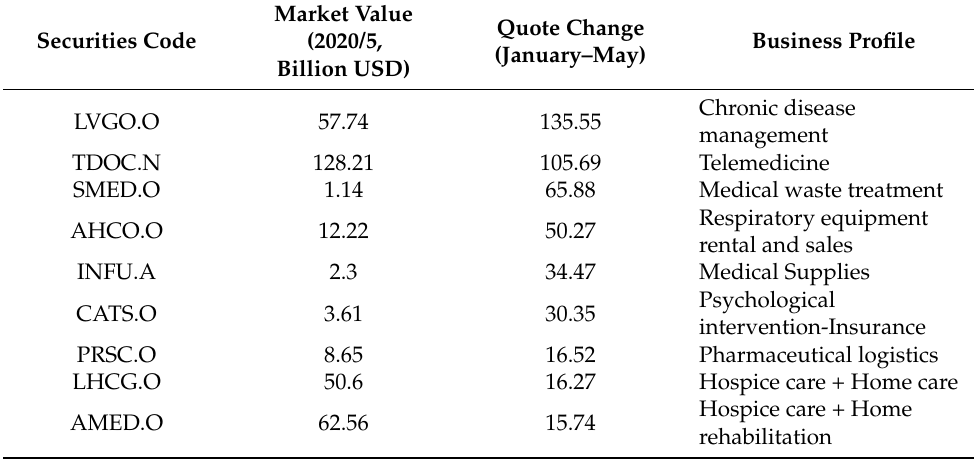
Table 4. The top nine medical service stocks in the U.S. for gains in 2020.